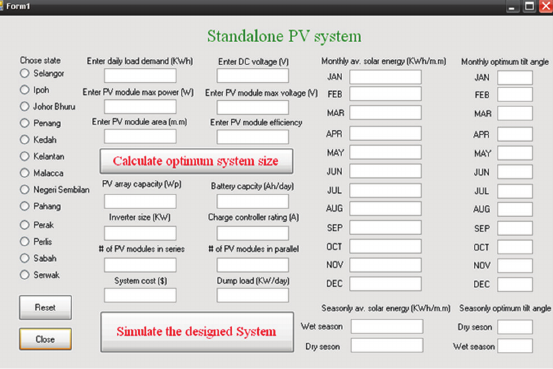
Figure 1: Procedures and calculations in the PV.MY.